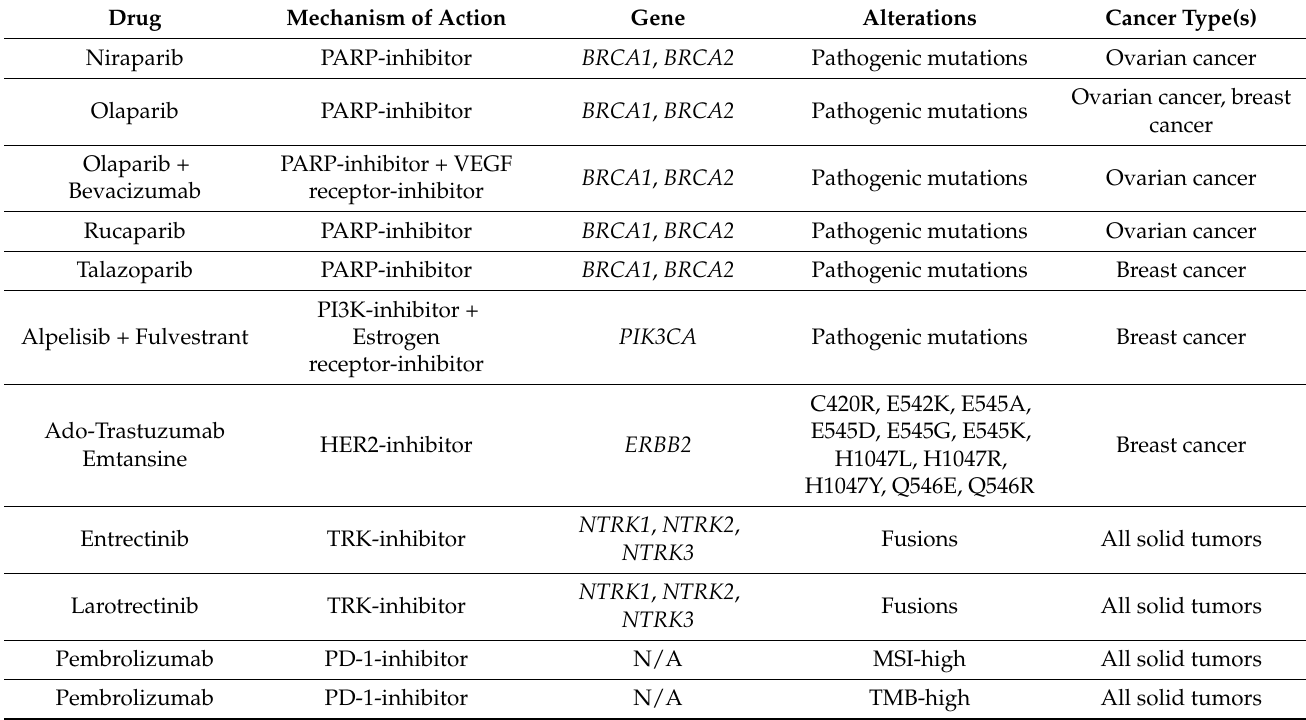
Table 1. List of selected FDA-approved molecular drugs for treatment of ovarian cancer and breast cancer patients.